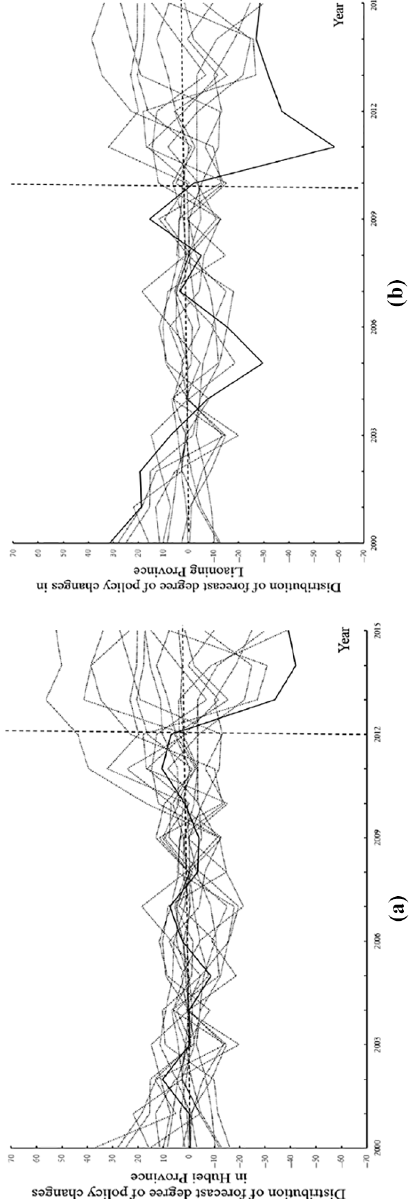
Figure 5. Distribution of policy changes in Hubei (a), Liaoning (b)